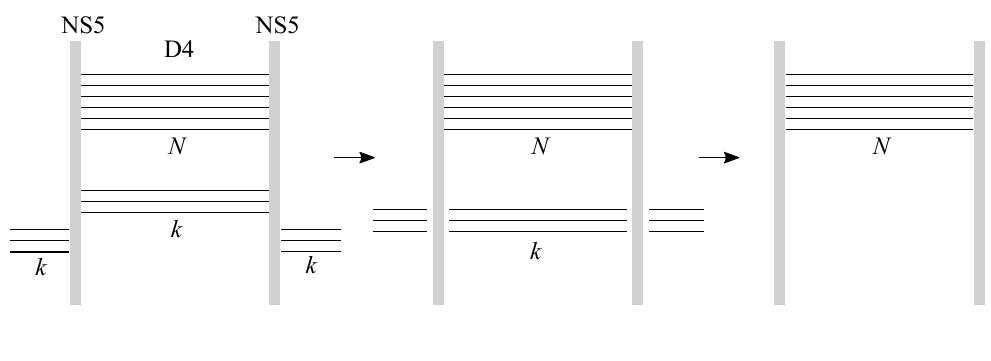
Figure 12 . A con(cid:12)guration of D4 branes suspended between two NS5 branes that reproduces a SU( N + k ) gauge theory with 2 k (cid:13)avors. This con(cid:12)guration can be Higgsed to a pure SU( N )